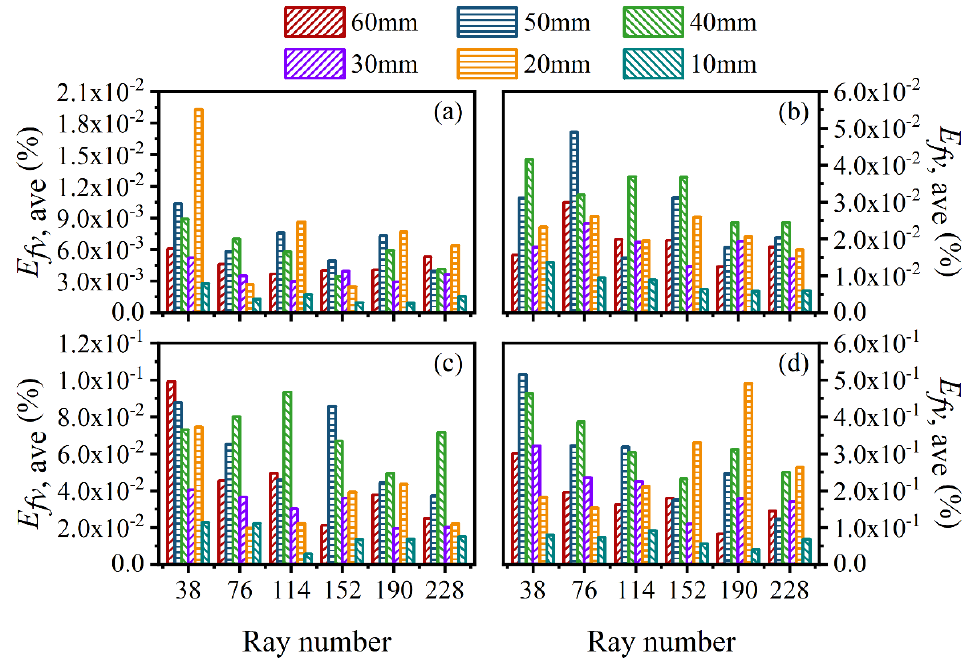
Figure 15. The average relative reconstruction error for soot volume fraction at the main cross-section in sooting regions. ( a ) SNR = 80 dB; ( b ) SNR = 65 dB; ( c ) SNR = 60 dB; ( d ) SNR = 46 dB.